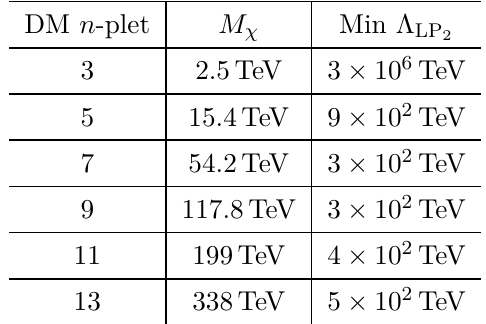
Table 4 . SU(2) n -plet WIMP thermal masses, for which the relic abundance of dark matter would be correctly reproduced and energy scale of the Landau pole, Λ LP couplings, all the extra fields up to the SM are added at the M χ